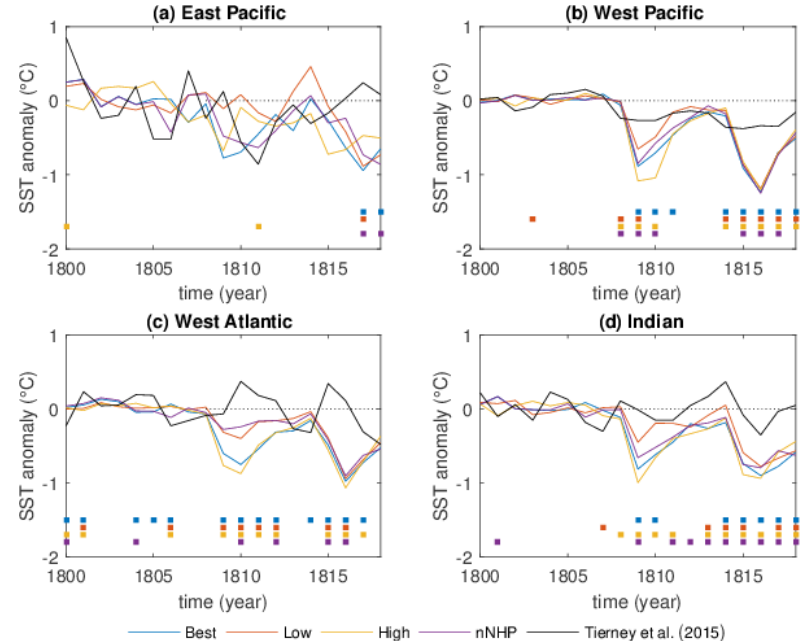
Figure 7. Coral–SST comparison. Comparison of reconstructed tropical annual mean SST (Tierney et al., 2015) with the MPI-ESM ex- periments over the (a) eastern Pacific (10 ◦ N–10 ◦ S, 175 ◦ E–85 ◦ W), (b) western Pacific (25 ◦ N–25 ◦ S, 110–155 ◦ E), (c) western Atlantic (15–30 ◦ N, 60–90 ◦ W), and (d) Indian (20 ◦ N–15 ◦ S, 40–100 ◦ E) oceans. Black solid line: SST reconstruction; colored lines: ensemble means of the model simulations. Anomalies are taken with respect to the years 1800 to 1808. The squares on the bottom of each panel indicate years when the observation lies outside the simulated ensemble range (color code as for the ensemble mean).